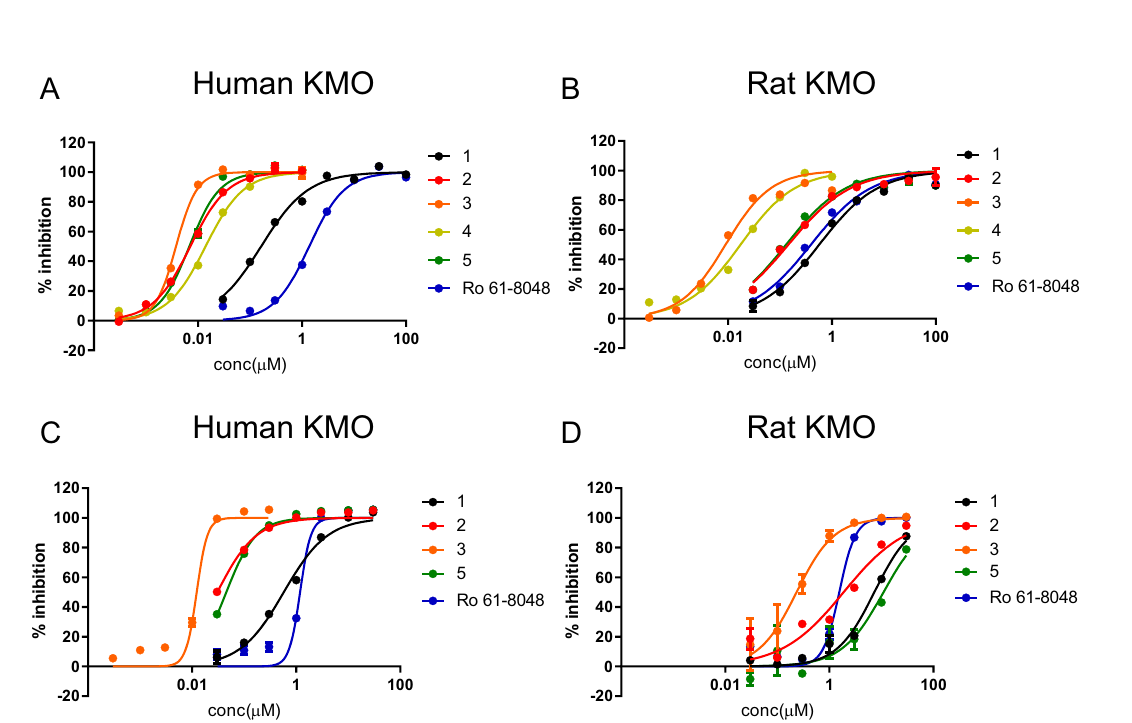
Fig. 1 KMO cell-free and cellular assay data. KMO cell-free assay data for A Hs-KMO and B Rat-KMO. KMO cellular assay data for C Hs-KMO and D Rat- KMO. Cell-free assays contained high concentrations of the substrate kynurenine and were quanti fi ed by detecting absorbance. Cellular assays were measured using